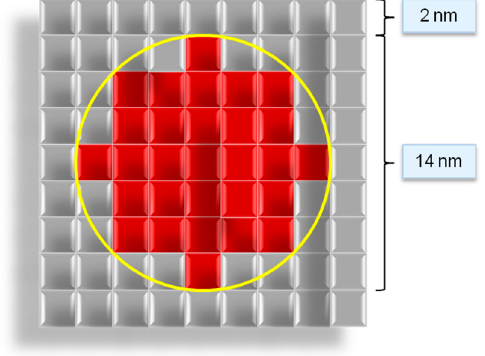
Figure 11. Cross-section of a digital representation of a 14 nm fiber with a 2 nm cell scale. Initially, the control points P 0 , P 1 , P 2 and P 3 are randomly selected on the field, P 0 and P 3 lie on one of the edges of the field. A Bezier curve is constructed from these control points in accordance with (1). Bezier curve passes through the points P 0 and P 3 and does not pass through points P 1 and P 2 . Cells which lie on the curve pass are set into "fiber" state. Further, the fiber diameter increases until it reaches the specified one. New fibers